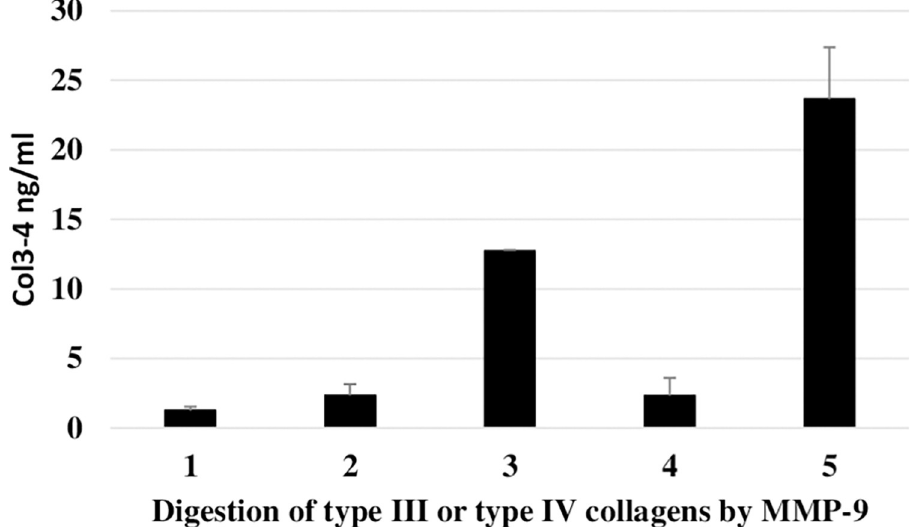
Fig 4. MMP-9 efficiently generated Col3-4 immunoreactivity from human type III and type IV collagen digestion. The graph shows the quantity of Col3-4 fragments measured by ELISA after incubation of human native type III collagen and recombinant type IV ( α 5) collagen with active recombinant human MMP-9 for 48h at 4˚C. Results are shown as bars with mean ± SD of 2 independent experiments. 1) MMP buffer + MMP-9; 2) MMP buffer + native